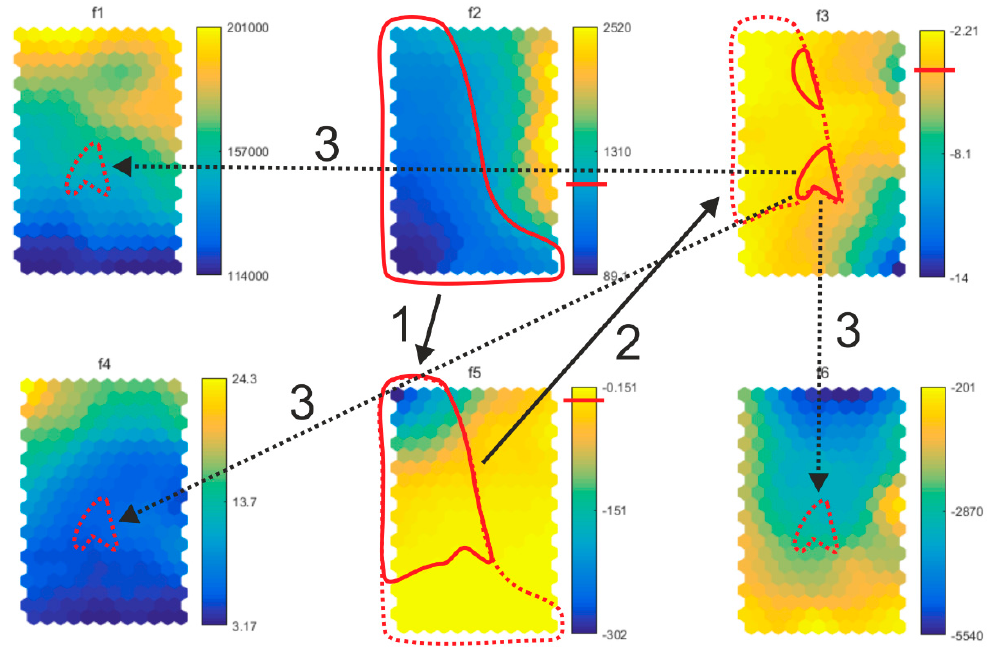
Figure 17. Example of selecting potentially interesting, compromise-solutions.